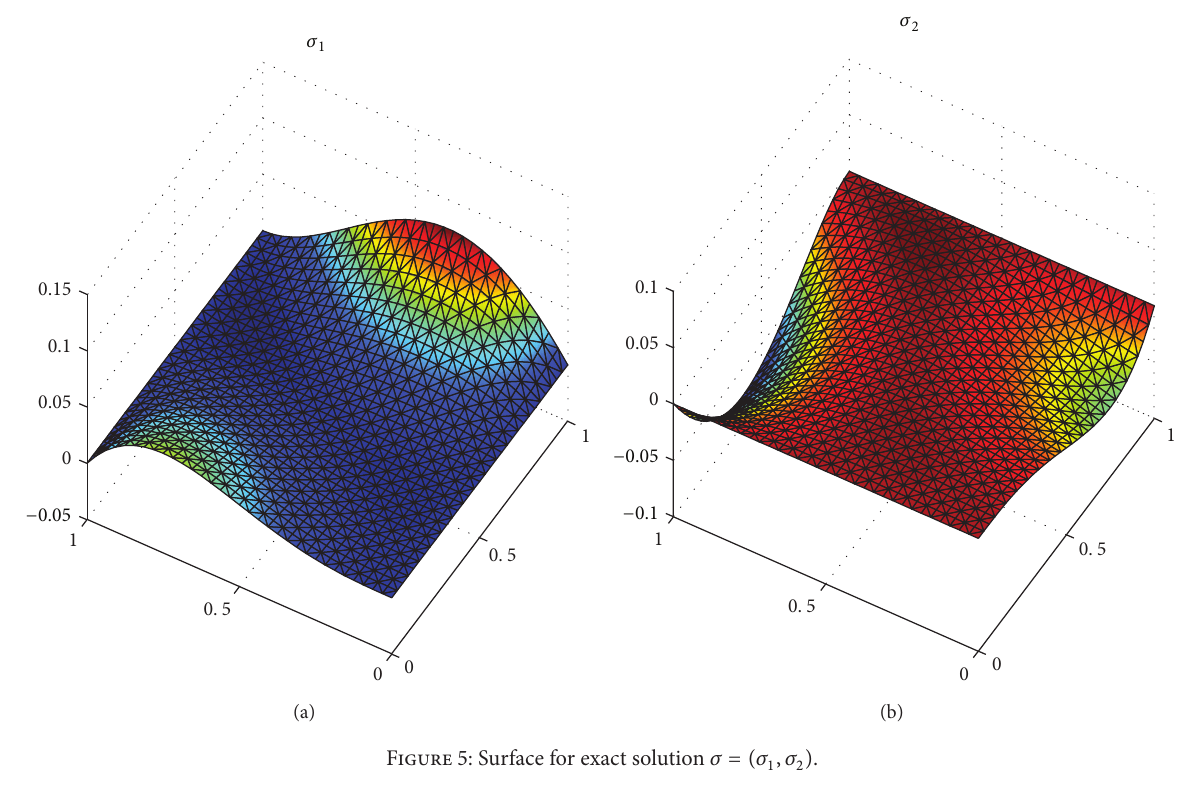
Figure 5: Surface for exact solution 𝜎 = (𝜎 1 ,𝜎 2 ) .